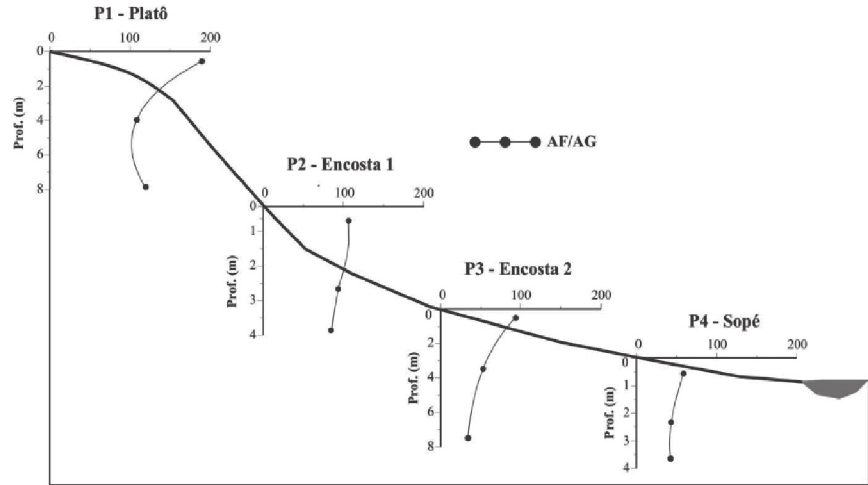
Figura 5. distribuição da relação areia fina/areia grossa (aF/ag) nos pontos estudados da